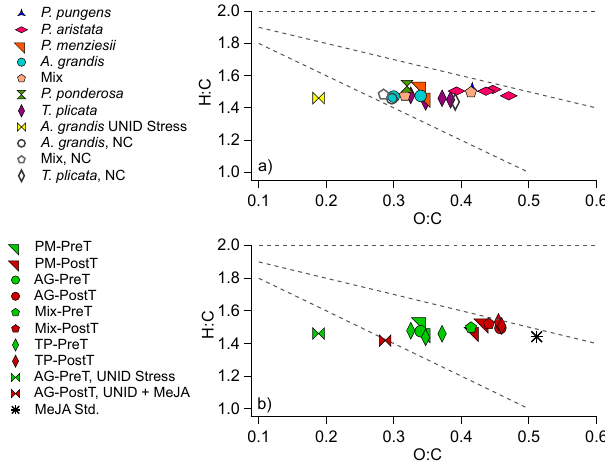
Figure 9. (a) Summary of the elemental analysis results from all pre-treatment SOA and negative control SOA. The pre-treatment experiment, AG-1-Pre, is labeled as an unidentified stress (UNID stress) experiment. NC is negative control. (b) Summary of el- emental analysis results from all experiments with paired pre- treatment/post-treatment SOA where a MeJA plant stress response was observed. Green markers denote pre-treatment SOA. Red mark- ers denote post-treatment SOA. The black asterisk illustrates the re- sults from the MeJA single-component standard SOA. The dashed lines are commonly included on Van Krevelen plots to indicate slopes of 0, − 1, and − 2, and are included here to put results in context with previous